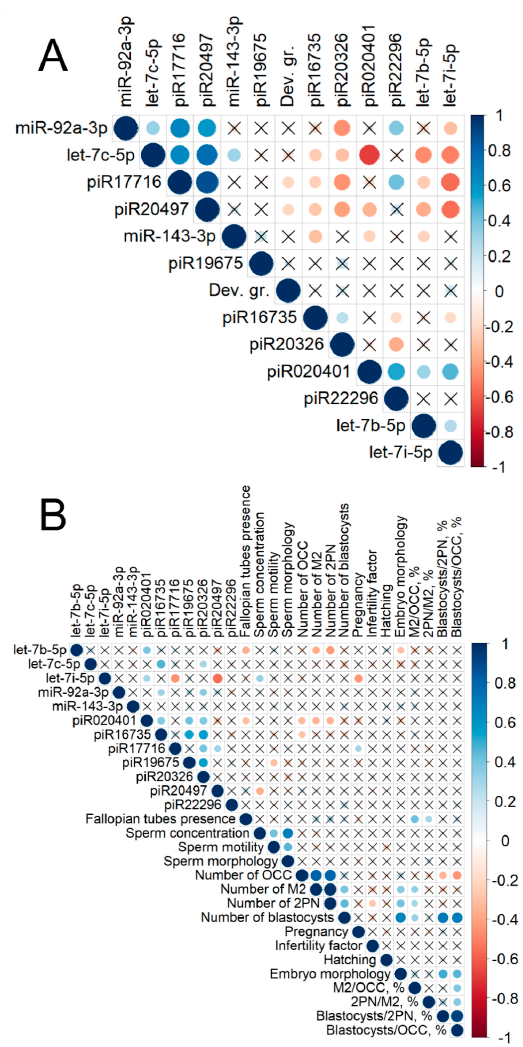
Figure 4. Correlation matrix based on the non-parametric Spearman rank correlation method. Significant ( p < 0.05) correlations are indicated by a dot, non-significant correlations are indicated by a cross, positive correlations are marked in blue, and negative correlations in red—the more significant the correlation, the larger the dot size. ( A ) Correlation analysis of the sncRNA expression level in 87 embryo cultivation medium samples and the quality of embryos. ( B ) Correlation analysis of the sncRNA expression level in 48 cultivation medium samples of embryos transferred to the uterus and the following parameters: fallopian tube presence—the presence of fallopian tubes in the female of each couple; sperm concentration—spermatozoid count per milliliter of ejaculate from the male of each couple; sperm motility—percentage of linearly motile spermatozoids from the male of each couple; sperm morphology—percentage of morphologically normal spermatozoids from the male of each couple; number of OCC—the number of oocyte–cumulus complexes from the female of each couple; number of M2—metaphase II oocyte number from the female of each couple; number of 2PN—two pronuclei embryo numbers from each couple; number of blastocysts—blastocyst number of each couple; pregnancy—the development of pregnancy after embryo transfer into the uterus; infertility factor—primary or secondary infertility in the female of each couple; hatching—embryo hatching before transfer to the uterine cavity; dev. gr.—embryo development stage and quality according to the Gardner grading scale; embryo morphology—morphological parameters of embryos according to the Gardner grading scale; M2 / OCC, %—metaphase II oocyte number as a percentage of OCC; 2PN / M2, %—number of two pronuclei embryos as a percentage of M2 oocyte; blastocysts / 2PN, %—blastocyst number as a percentage of 2PN embryos; blastocysts / OCC, %—blastocyst number as a percentage of